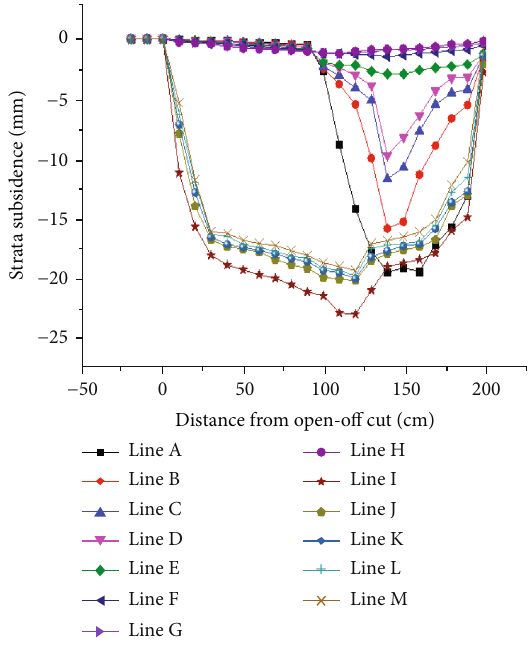
Figure 15: Displacement curve of the J coal working face advanced to 100